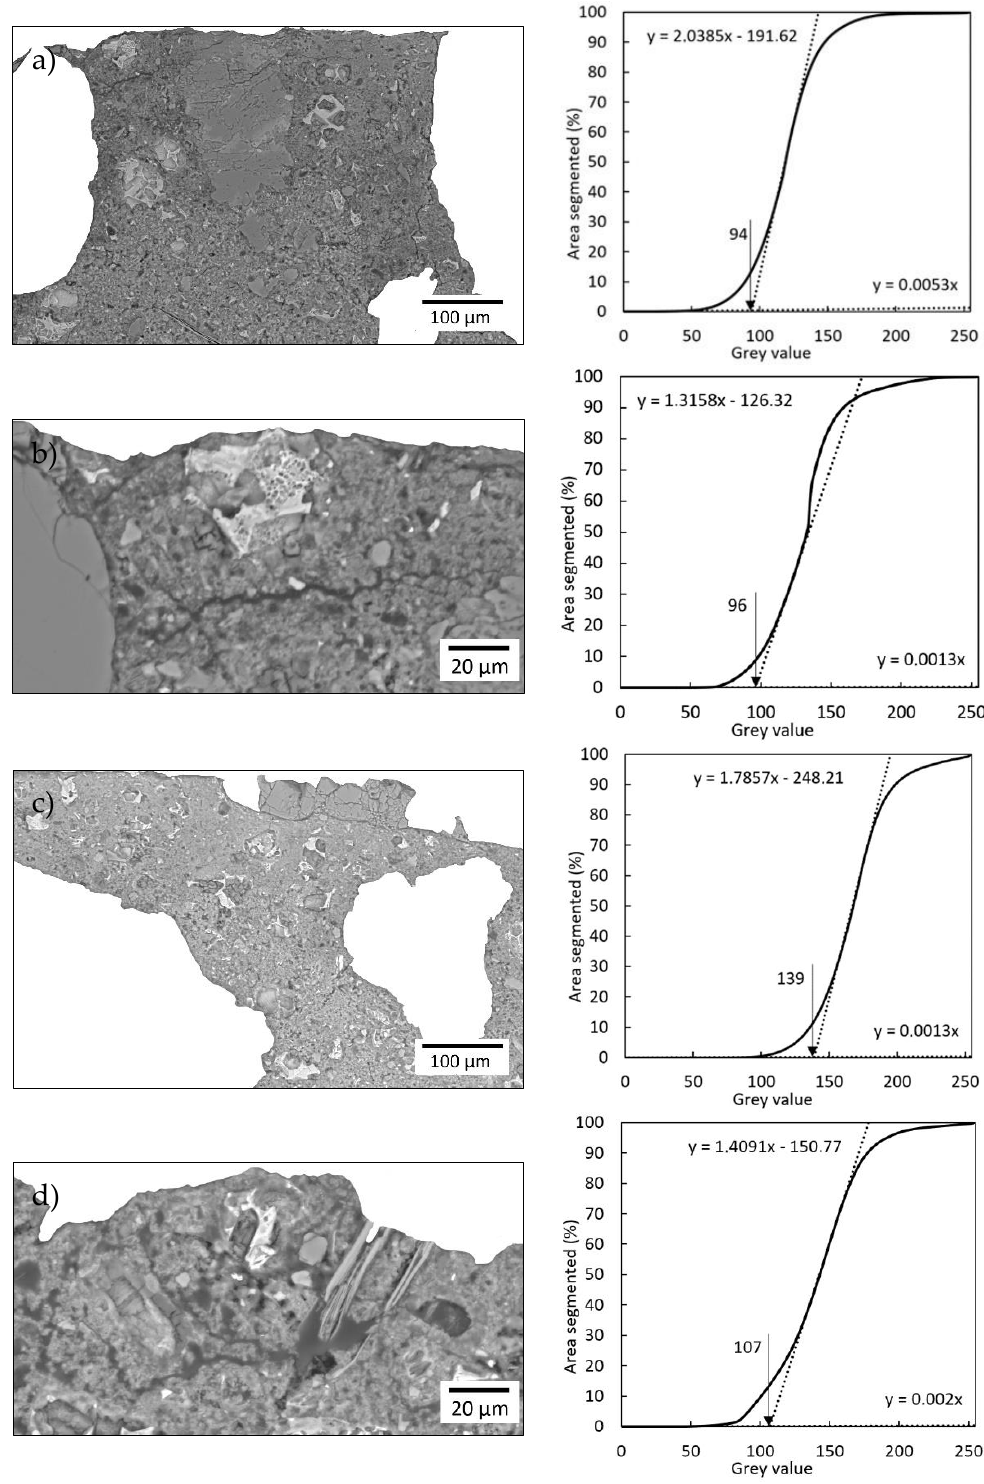
Figure 19. Images at x200 magnification after processing using the ImageJ program and cumulative greyscale histogram for: ( a , b ) unmodified sample, ( c , d ) sample modified with 0.5% of polypropylene fibers.